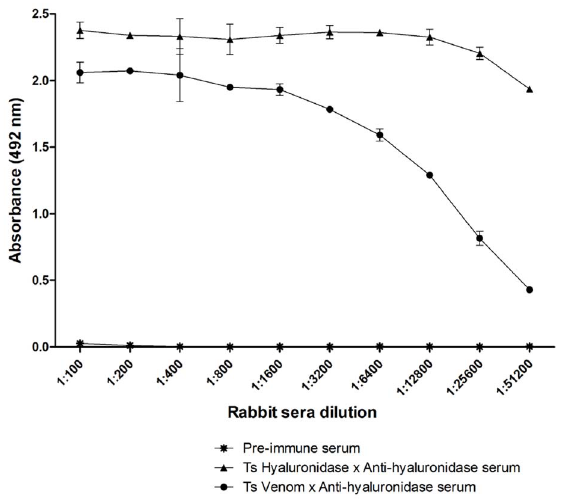
Figure 4. In vitro rabbit anti-hyaluronidase serum reactivity. Reactivity of rabbit anti-hyaluronidase serum with native hyaluronidase N purified from Tityus serrulatus venom ( m ) or crude Tityus serrulatus ). Pre-immune serum (*) was used as a negative control. ELISA venom ( plates were coated with native hyaluronidase purified from Tityus serrulatus venom (5 m g/ml) or crude Tityus serrulatus venom (5 m g/ml). Rabbit anti-hyaluronidase serum was diluted from 1:100 to 1:51,200. A 492 values shown are the means 6 S.E.M. of duplicates.